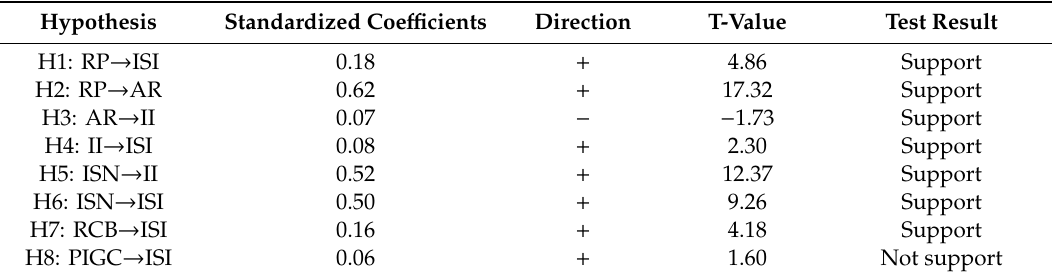
Table 6. Table 6. Results from hypotheses tests between different latent variables in the Structural Equation Model.